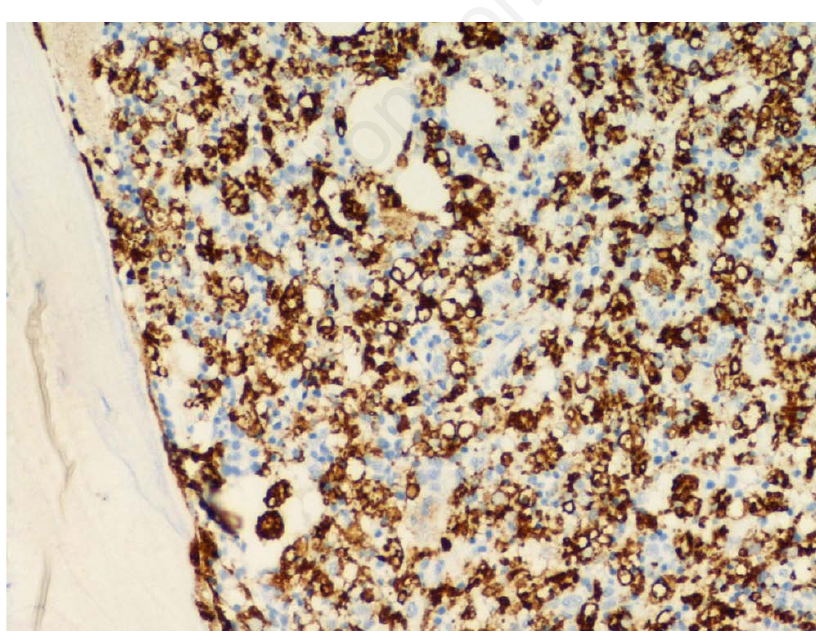
Figure 3. Bone marrow biopsy: CD68 immunostain shows a diffuse histocyte infiltrate in hypercellular